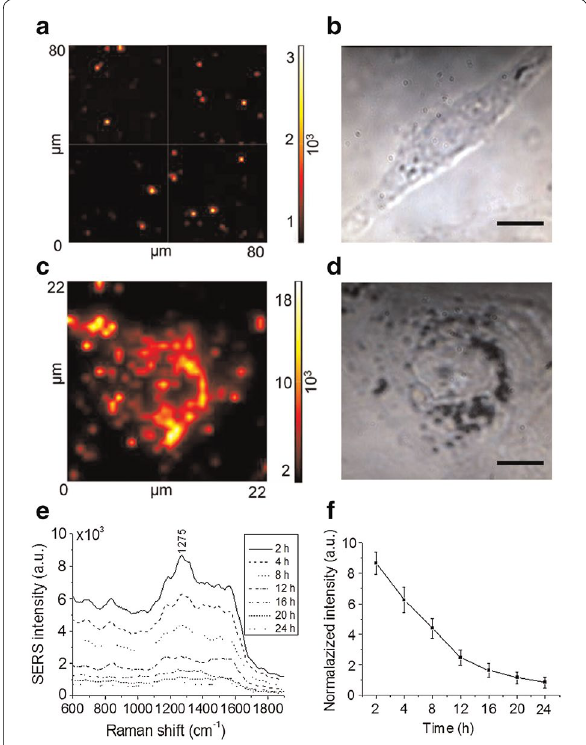
Fig. 5 Confirmation of specific cell targeting using biohybrid nanoparticles and time dependent release of Dox inside cells. a , c SERS map images of biohybrid nanoparticles added to co‑cultured SH‑SY5Y and SK‑BR‑3 cells respectively. SERS mapping images were measured at the 1275 cm − 1 Raman band. b , d Bright‑field images of the SH‑SY5Y and SK‑BR‑3 cells respectively. (scale bar: 20 μm ( b ), and 5 μm ( d )). e SERS spectra of the SK‑BR‑3 cells treated with Dox loaded biohybrid nanoparticles at different incubation times. f Relationship between time and release of Dox. The error bars indicate the standard deviation of ten measurements in three individual cells (Reprinted with permission from [87]. Copyright @ 2015